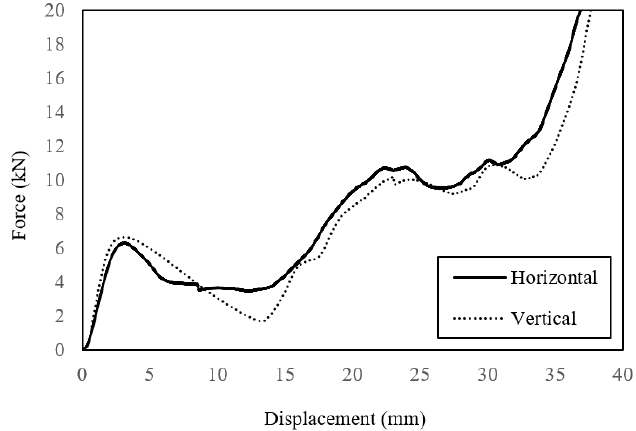
Figure 9. Load–displacement traces following compression tests on lattice structures (n = 1) built vertically and horizontally.